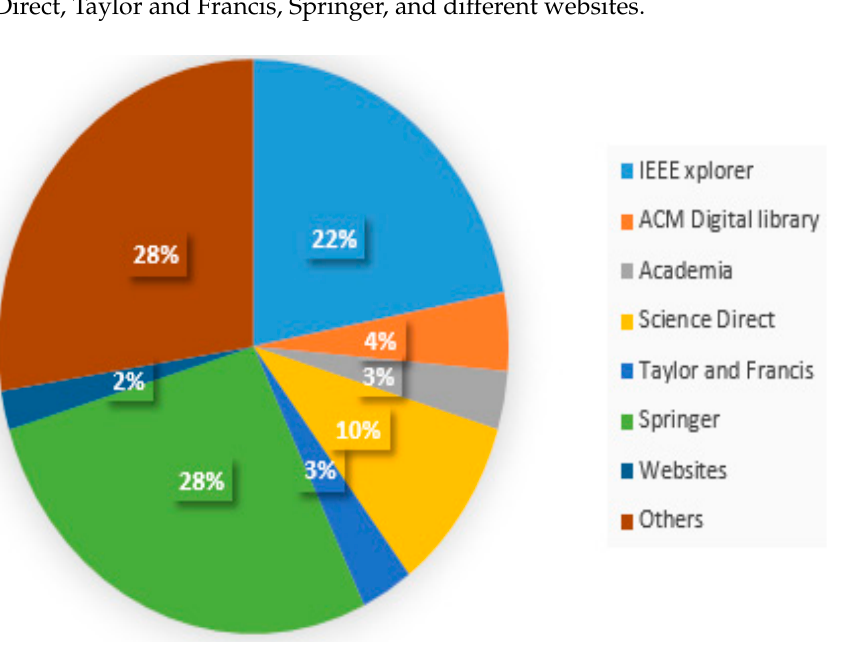
Figure 3. The percentage of a research paper read from multiple sources from 2015 to 2021.